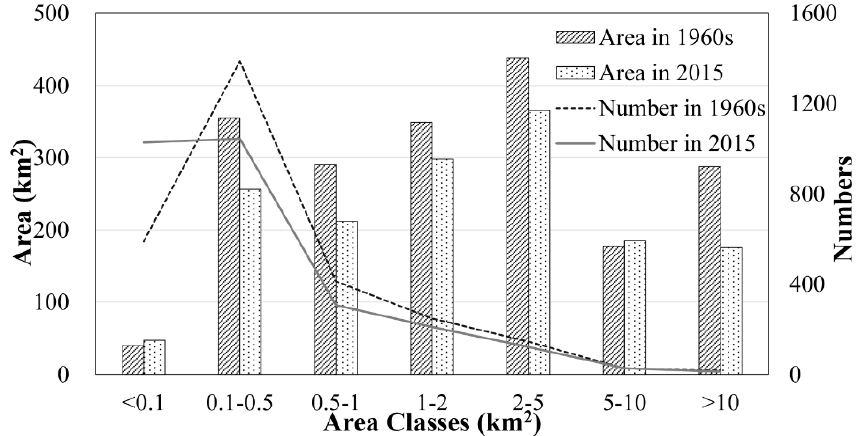
Figure 4. Size and count distributions of glacier in different area classes from three inventories.